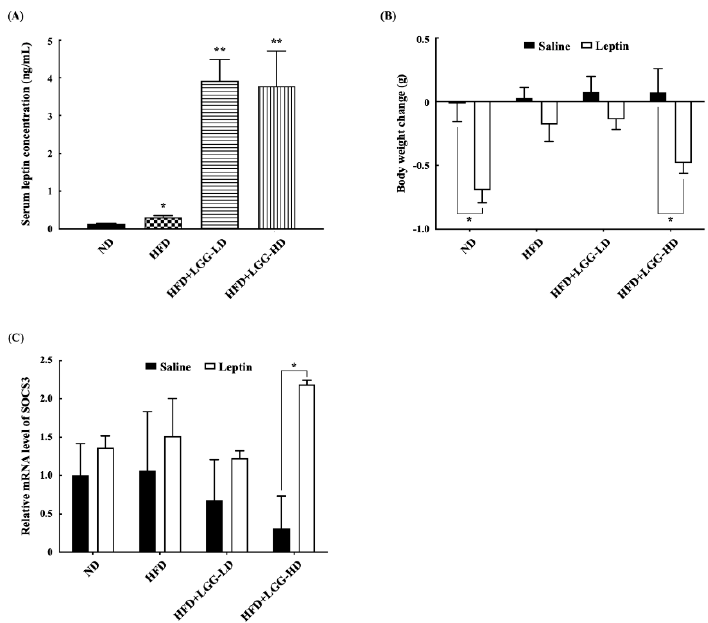
Figure 3. Effect of administration of Lactobacillus rhamnosus GG (LGG) on serum leptin concentrations and leptin responsiveness to exogenous leptin treatment of mice with diet-induced obesity. ( A ) Serum leptin concentrations. Bar marked with a star * or double stars ** means that it is significantly different from the ND group at p < 0.05 or p < 0.01, respectively. ( B ) Body weight change after treatment with exogenous leptin. Bar marked with a star * means that it is significantly different from the control (saline) at p < 0.05. ( C ) Relative hypothalamic mRNA expression level of SOCS3 gene. The data are expressed as relative fold change compared with the ND group given saline, which is set as 1. Bar marked with a star * means that it is significantly different from the control (saline) at p < 0.05. ND: normal diet; HFD: high-fat diet; HFD+LGG-LD: high-fat diet supplemented with low-dose LGG (10 8 CFU/mouse/day); HFD+LGG-HD: high-fat diet supplemented with high-dose LGG (10 10 CFU/mouse/day). All data are expressed as mean ± SD ( n = 5).